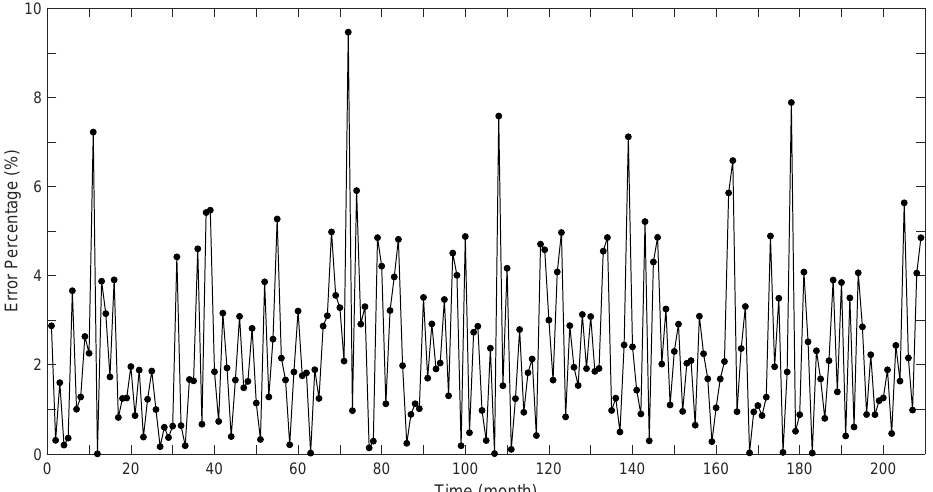
Figure 8. The error percentage of the prediction in the test